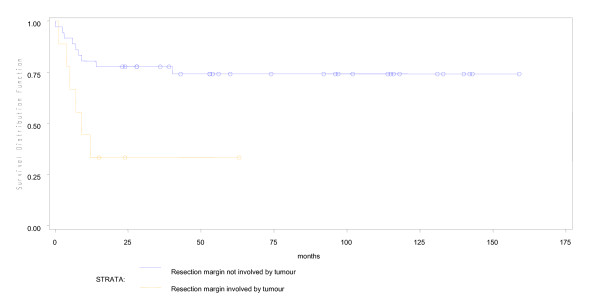
Involvement of the resection margin by microscopic tumour and disease-free survival.